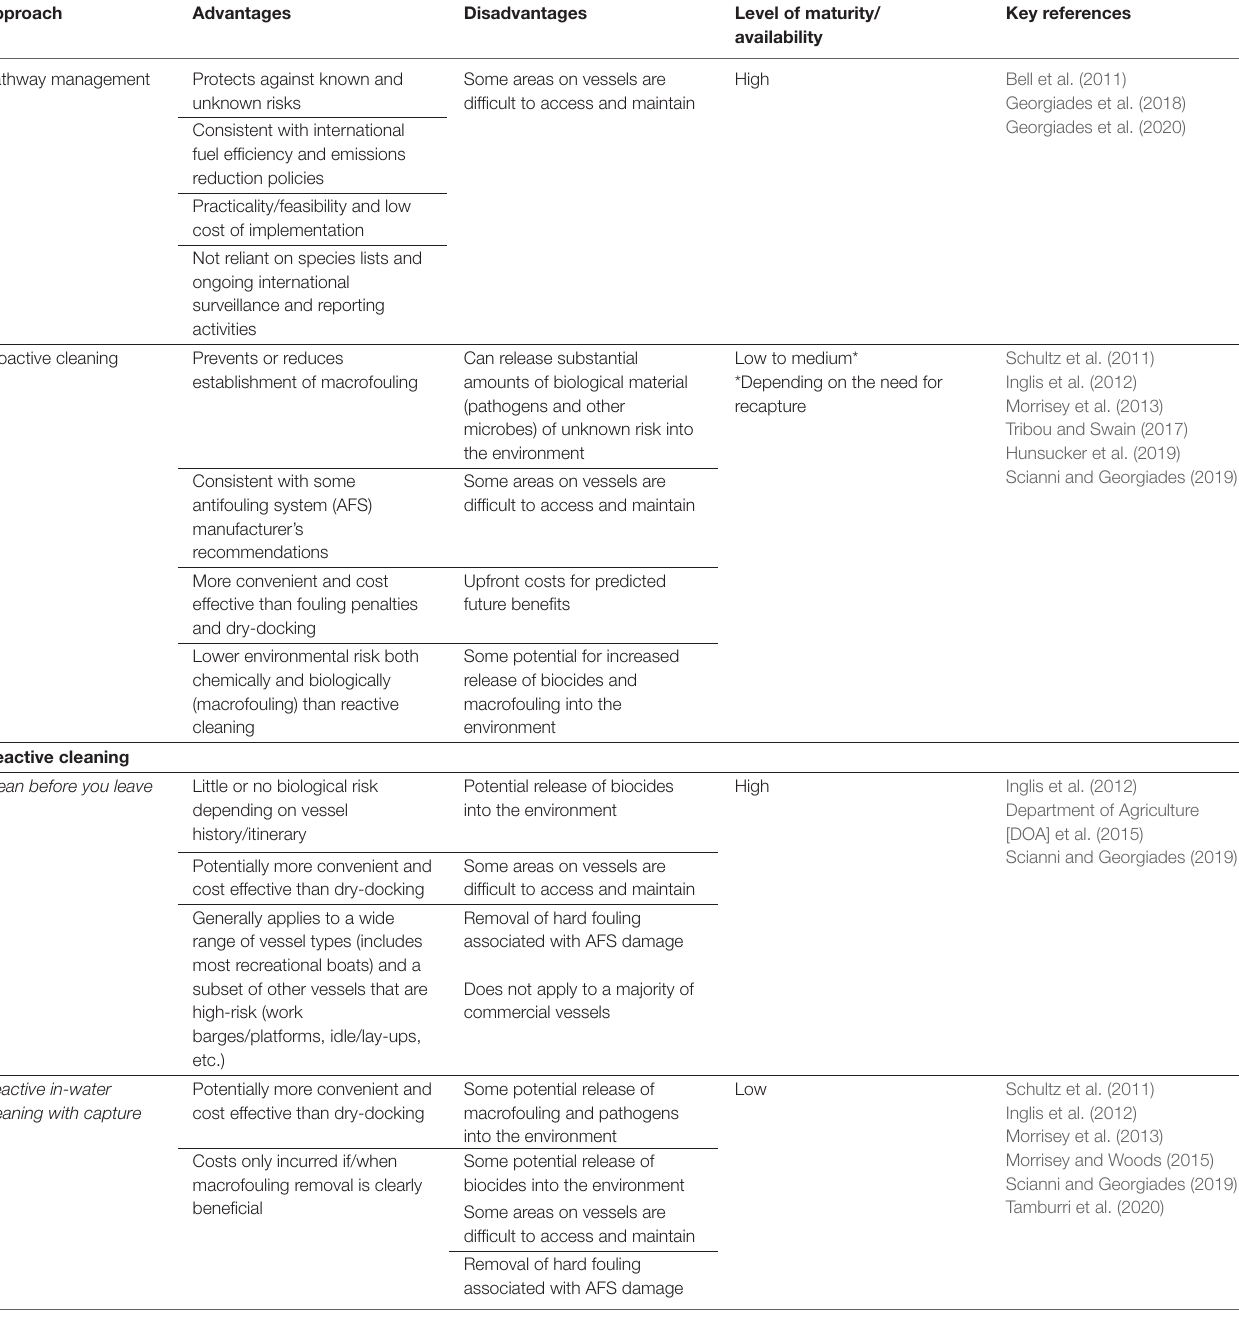
TABLE 4 | High-level approach for management of pathogen translocation via vessel